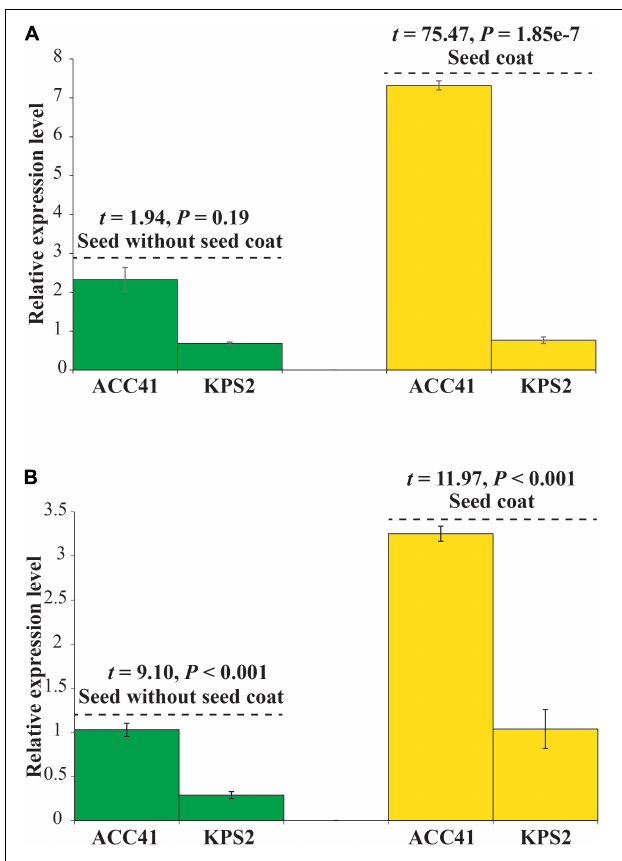
FIGURE 7 | Relative gene expression level of VrKNAT7-1 ( LOC106767068 ) (A) and VrCYP86A ( LOC106774045 ) (B) in a seed without seed coat and with the seed coat of ACC41 and